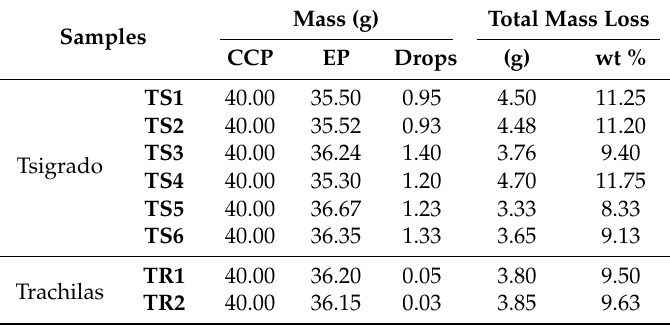
Table 1. Mass values of coarse crude (CCP), expanded perlite (EP) samples and drops of expanded